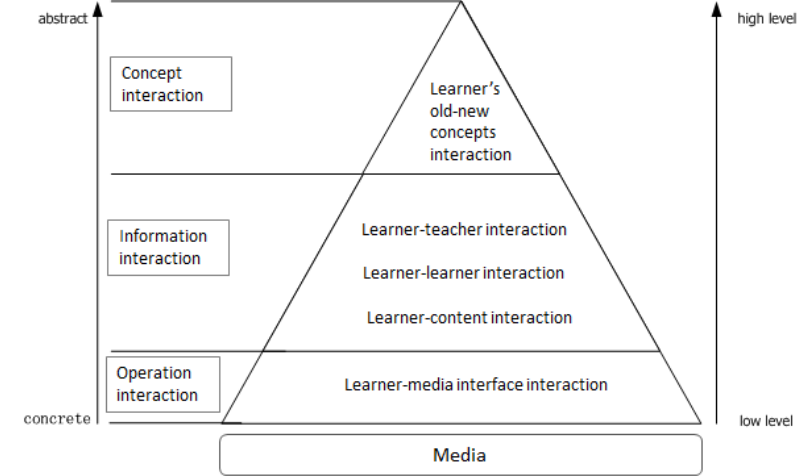
Figure 1. Hierarchical model for instructional interaction (HMII) (Chen,